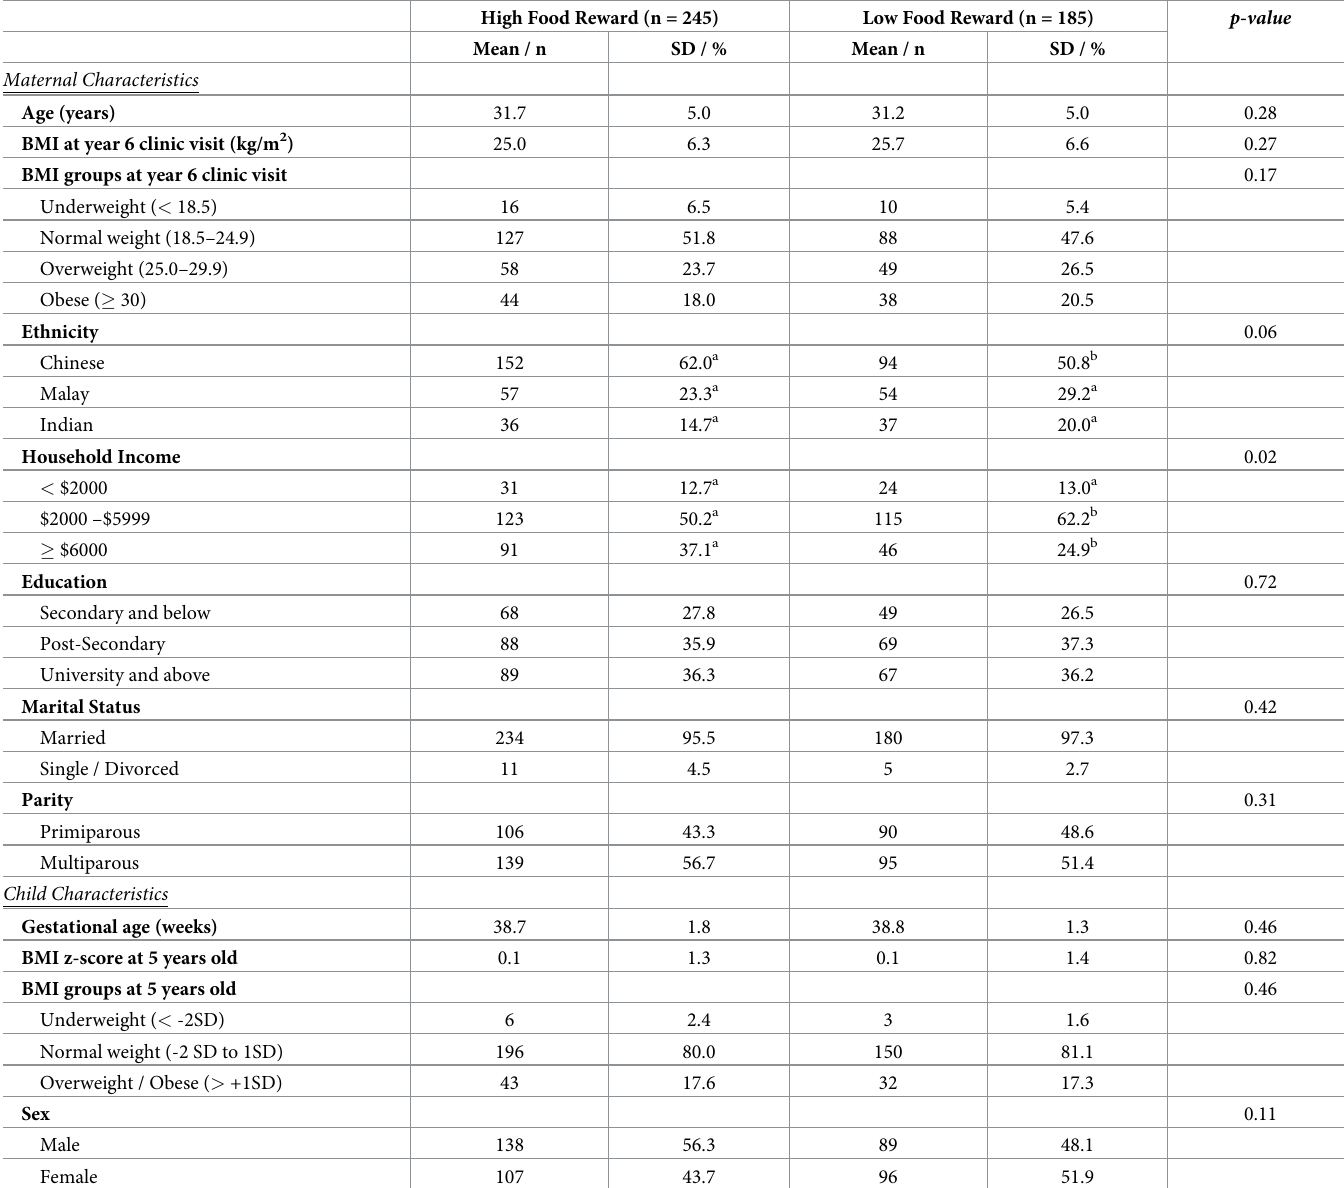
Table 1. Maternal and child